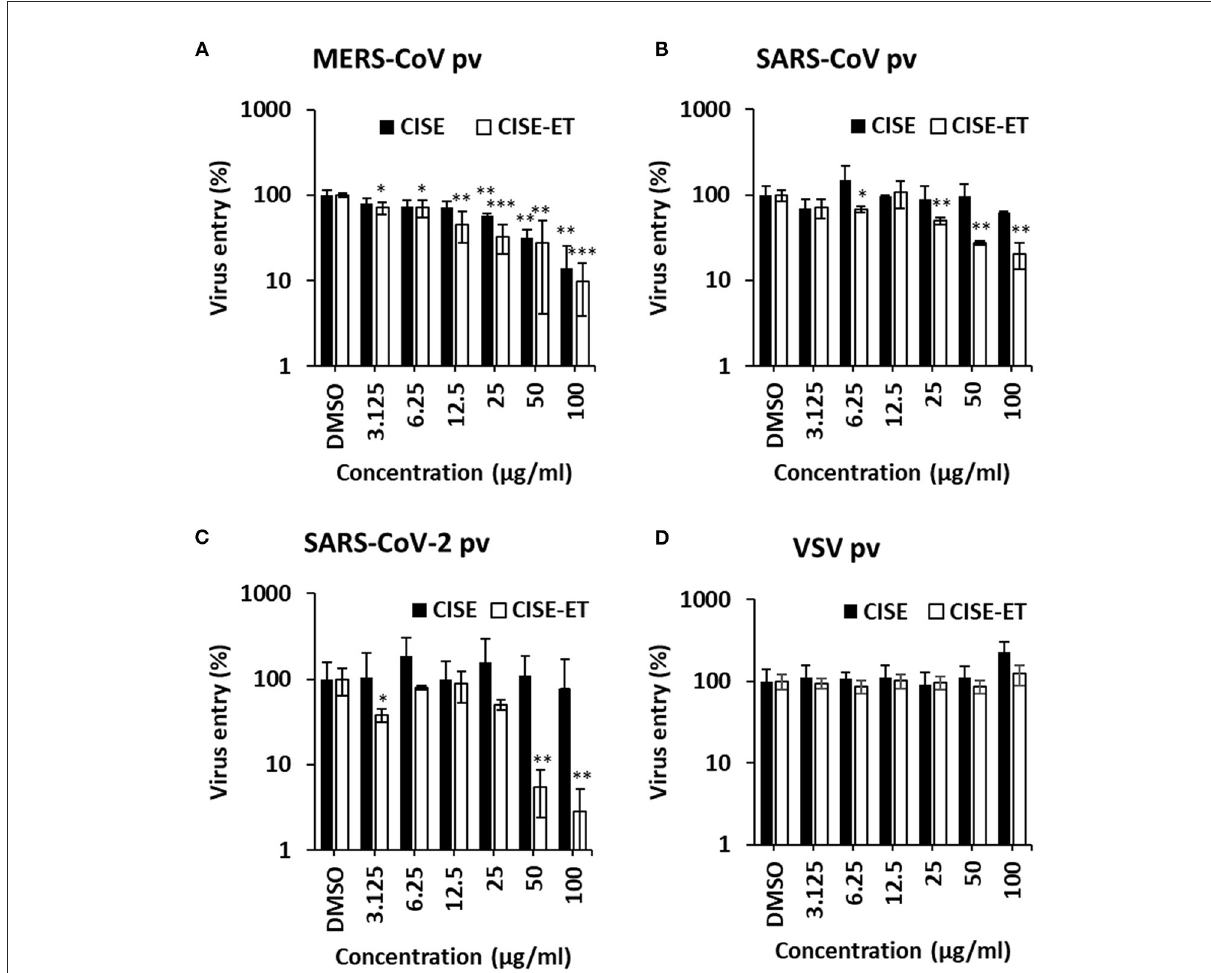
FIGURE6 CISE-ET inhibited the entry of MERS-CoV, SARS-CoV and SARS-CoV-2. Huh7 cells were transduced with MERS-CoV (A) , SARS-CoV (B) , SARS-CoV-2 (C) or VSV (D) pseudotyped viruses (pvs) in the presence of various concentrations of CISE or CISE-ET. The viral entry was quantified by a luciferase assay at 48h post-transduction and expressed relative to that found for the DMSO control group. The error bars represent the SDs from the means ( n = 3). * P < 0.05; ** P < 0.01; *** P <